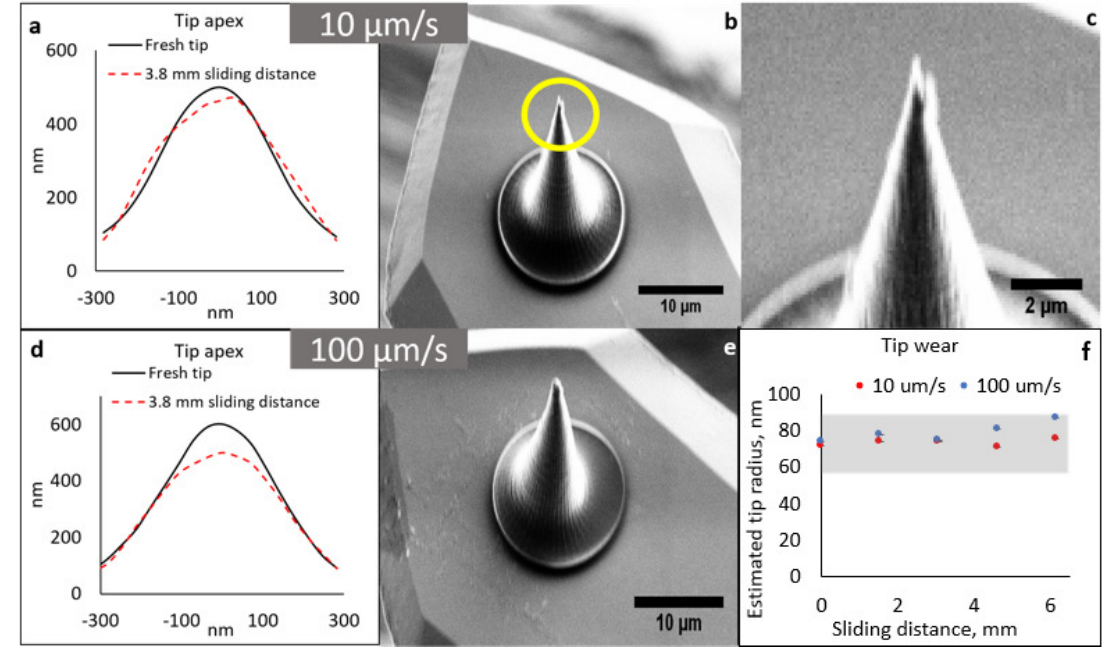
Figure 3. Wear tests for glassy carbon tips. ( a ) Pre- and post-wear tip-apex profiles and ( b ) corresponding post-wear SEM micrograph at 10µm/s scan velocity. Magnified image of the apex of the tip in ( b ) (highlighted by a circle) is shown in ( c ); ( d ) pre- and post-wear tip-apex profiles and ( e ) corresponding post-wear SEM micrograph at 100µm/s scan velocity; ( f ) Measured change in tip radii at 10 and 100µm/s scan velocities at various sliding